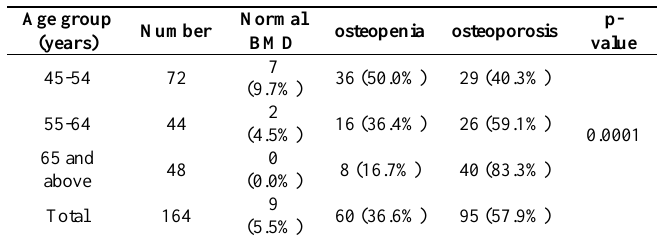
Table 1 : Distribution of BMD (by QCT) among post-menopausal women